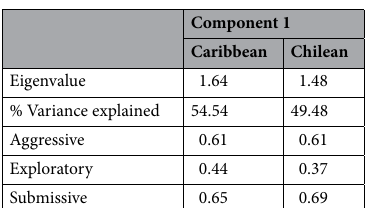
Table 1. Extraction results of the PCA of the three personality traits, aggressive, exploratory and submissive, for the separate